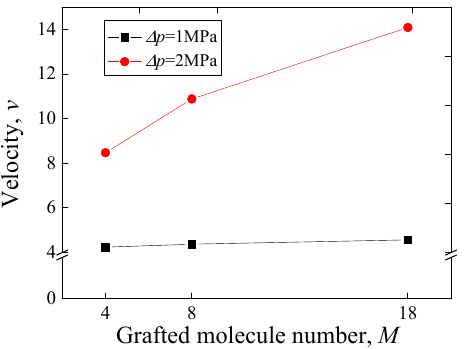
Figure 4. Fractal percolation model velocity of 10-100 C M silica gel.